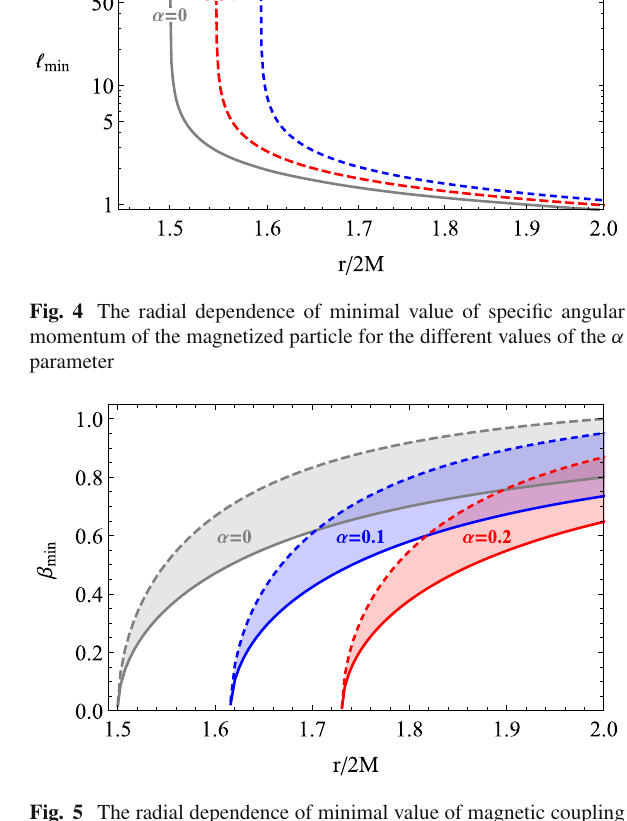
Fig. 5 The radial dependence of minimal value of magnetic coupling parameter of the magnetized particle for the different values of the α parameter.Gray,light-blueandlight-redcoloredareascorrespondtothe values of MOG parameter α = 0, α = 0 . 1 and α = 0 . 2,